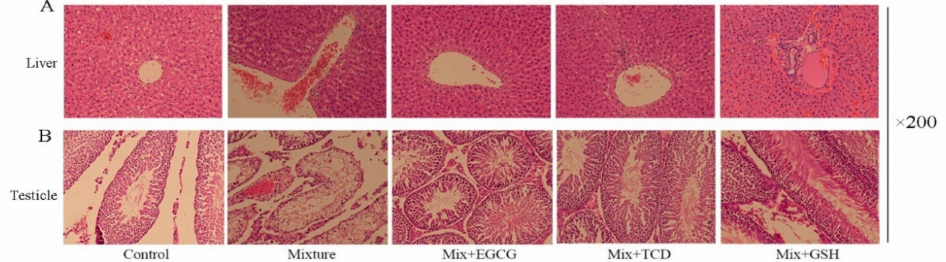
Figure 2. E ff ects of exposure to a heavy metal mixture on histomorphology of liver and testicle with or without the addition of EGCG, TCD or GSH. The formalin-fixed tissues were stored at 4 ◦ C and the histopathological examination lasted two months. Mix, Mixture.